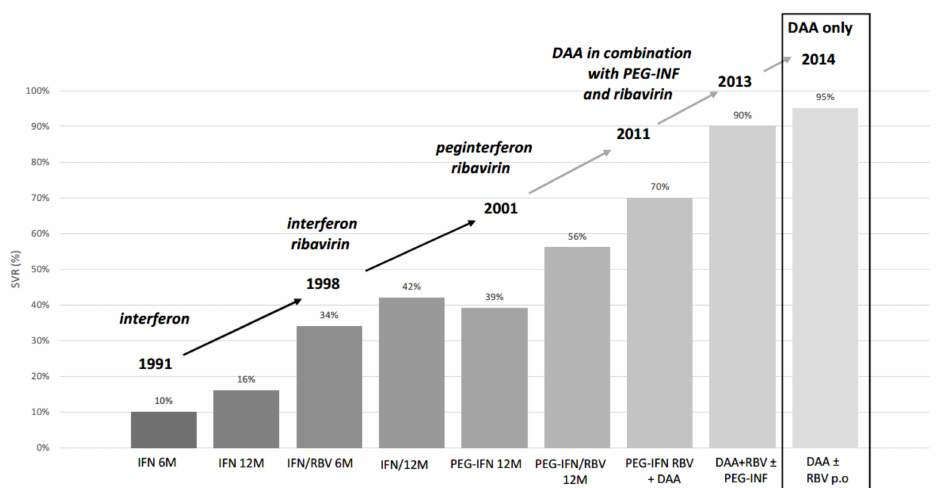
Figure 1. WHO goals in treatment of hepatitis C infection [4].